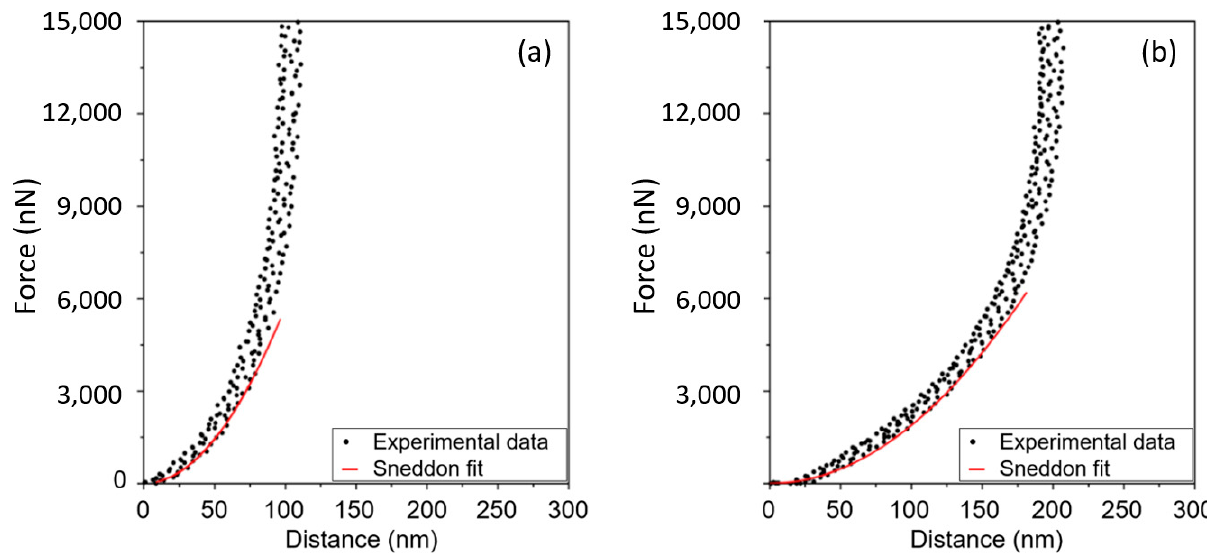
Figure 3. Force–distance curves of the tested bio-polyesters: ( a ) PLA; ( b ) P(3 HB-co-88% 3 HV).